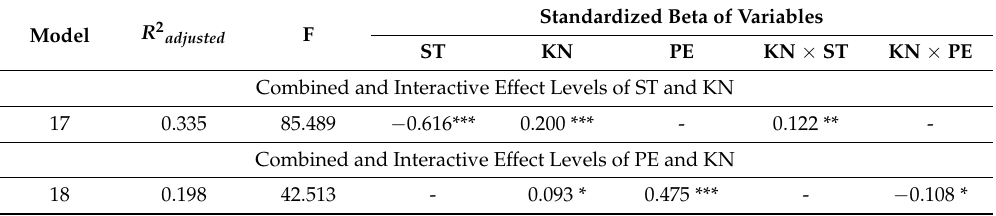
Table 7. Summary of combined and interactive effect levels on anxiety by multiple linear regression analyses of knowledge and social trust, pessimism,